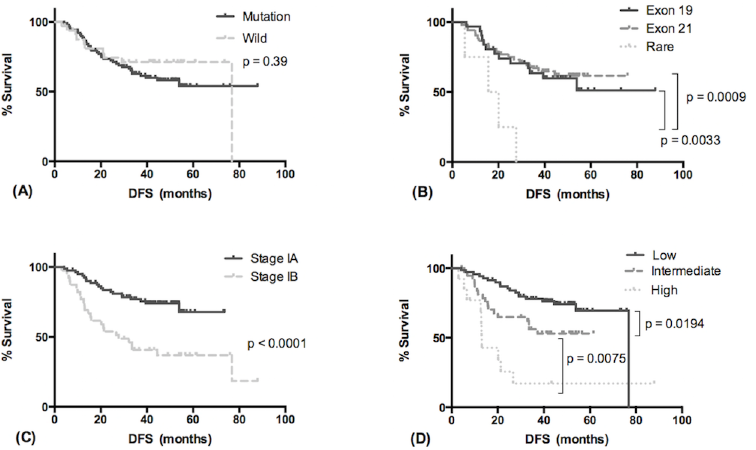
Fig 1. Disease-free survival of patients with stage I resected pulmonary adenocarcinoma. (A, B) Disease-free survival in relationto EGFR mutation status. (C) Disease-free survival in relationto tumor pathologic stage. (D) Disease-free survival in relationto tumor histological classification.